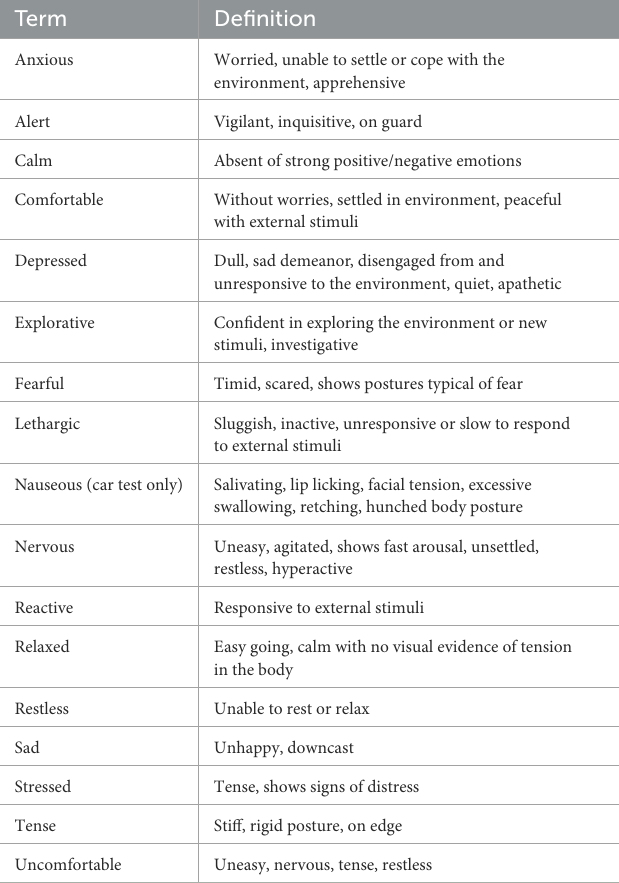
TABLE 1 Terms included in the Qualitative Behavioral Assessments (QBA) used to measure dog behavior during baseline, the separation, and car travel